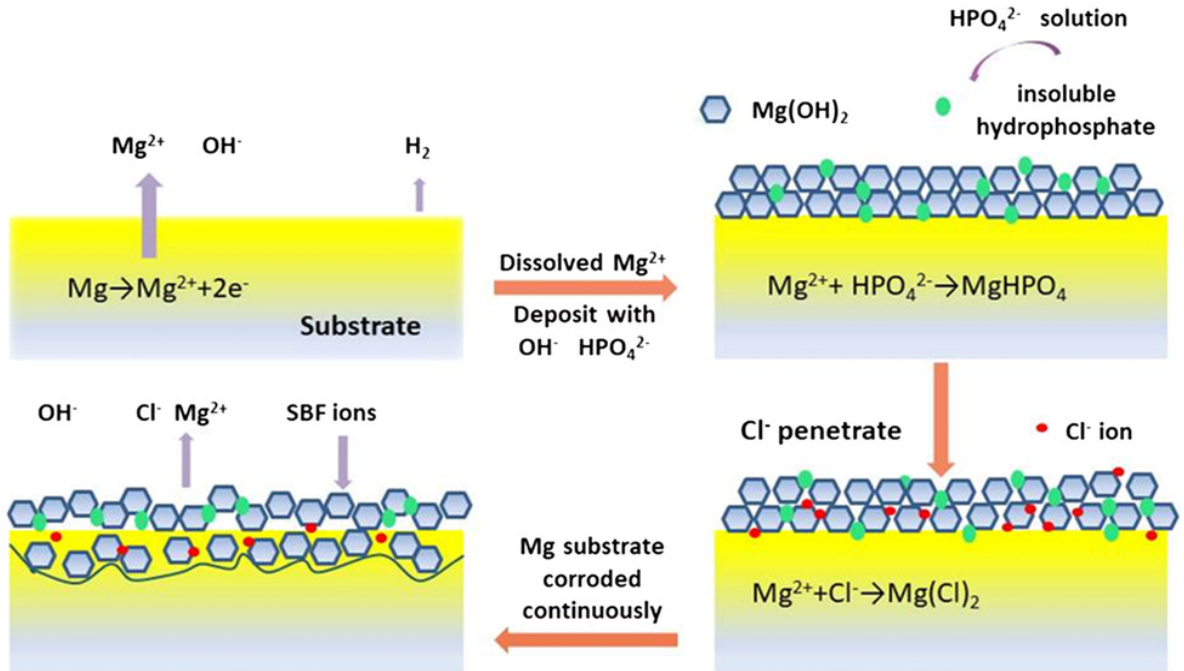
Figure 2. A schematic illustration of corrosion mechanisms in Mg-based alloys in a simulated body fluid (SBF) solution [70]. Table 1. Solubility data for binary Mg-based alloys [88–90].